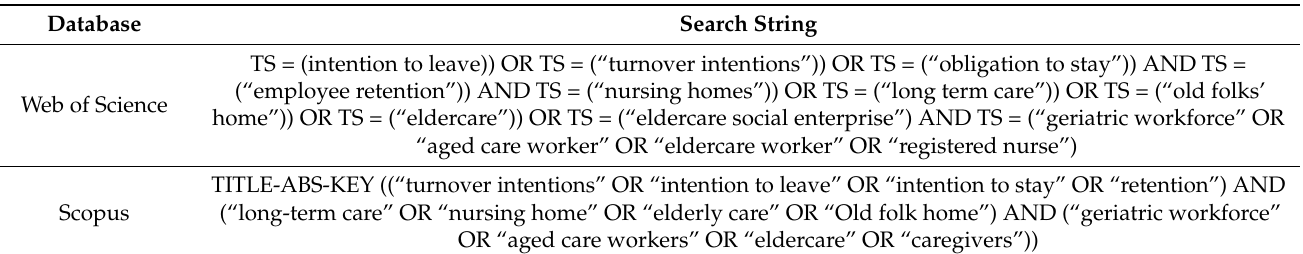
Table 1. Search strings for the main databases.